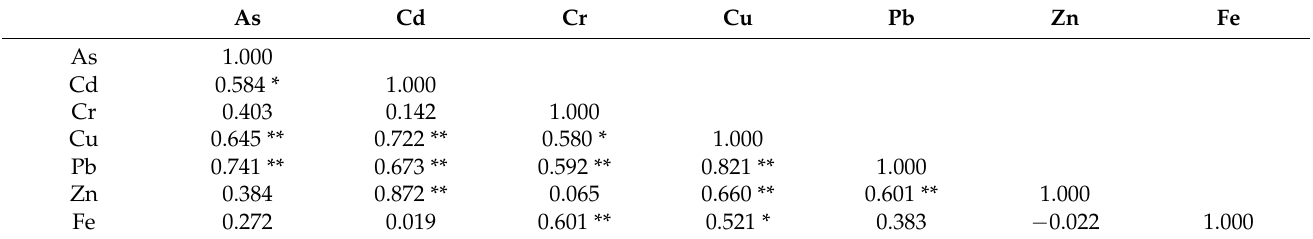
Table 1. Pearson correlation coefficient between heavy metals in Manwan (M) and Dachaoshan (D) cascading dams. ** means significant correlation at 0.01 level (bilateral); * means significant correlation at 0.05 level (bilateral).